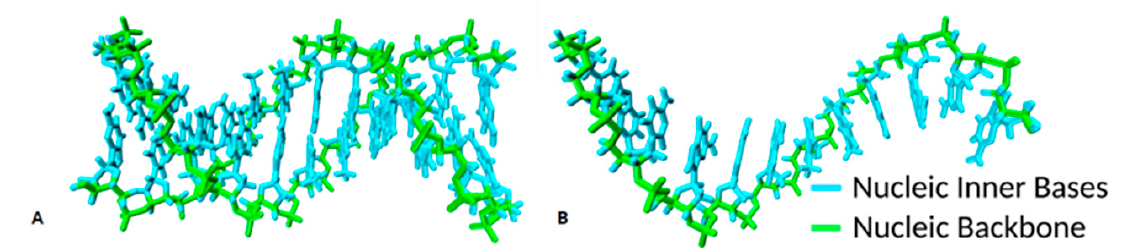
Figure 1. The two DNA molecules used, generated with the sequence 5’-CGCGAATTCGCG-3’: ( A ) Double-stranded deoxyribose nucleic acid (dsDNA); ( B ) Single-stranded DNA (ssDNA).